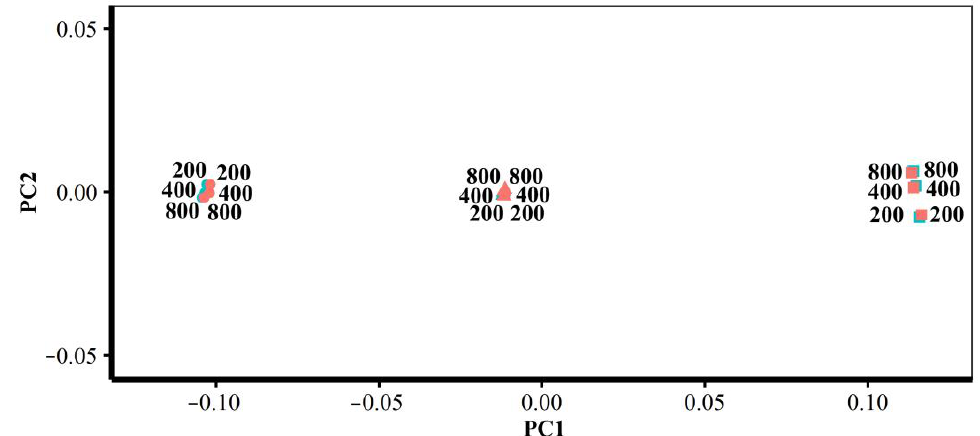
Figure 18. PC1 (99.5% of total variance) vs. PC2 (0.15%) from PCA of the mean and allometrically scaled head surfaces derived using varying densities of semilandmarks and the sliding TPS and TPS&NICP semilandmarking approaches. Triangles = means, squares = allometric predictions of surfaces at the sample minimum centroid size, circles = allometric predictions of surfaces at the sample maximum centroid size. Red = sliding TPS, blue = TPS&NICP. Numbers indicate number of semilandmarks. Means are nearly superimposed.